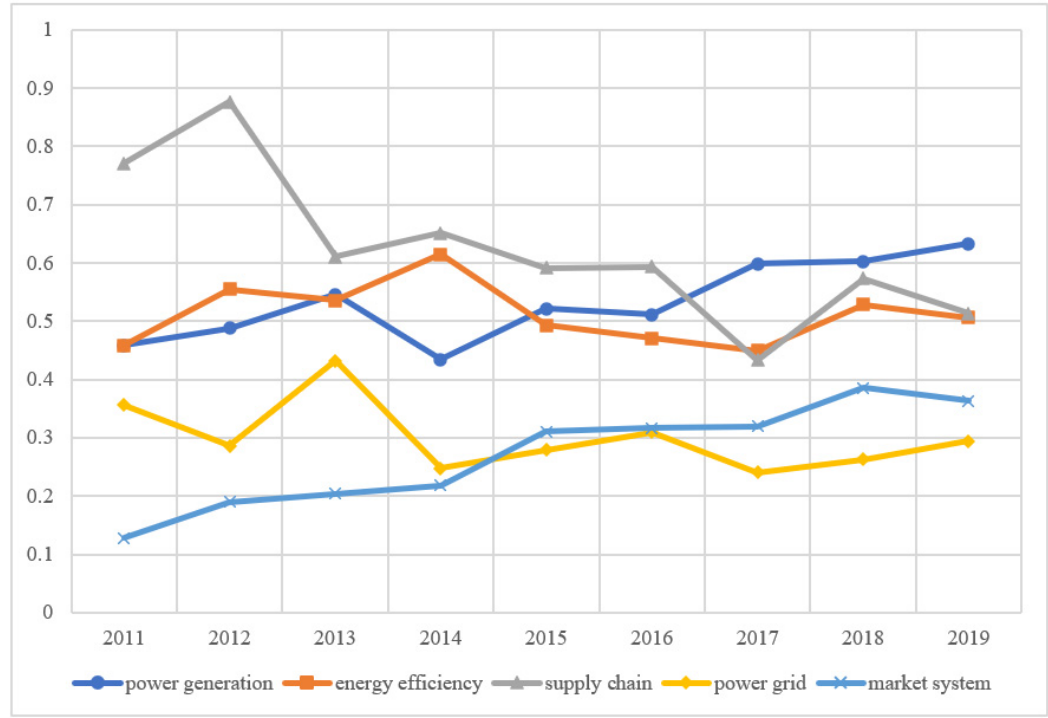
Figure 4. Evaluation score of low-carbon development in central China.